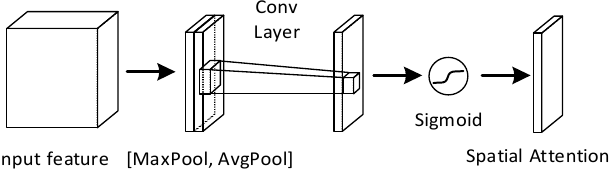
Figure 2. Diagram of spatial attention module (SAM). As illustrated, the spatial attention module forwards max pooling outputs and average pooling outputs to the convolution layer and generates spatial attention through the sigmoid function.